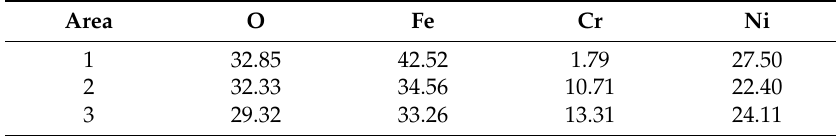
Figure 4. ( a ) Microstructure of the repaired Inconel 718 specimen and ( b ) energy-dispersive spectroscopy (EDS) mapping of the Laves phase. Table 1. EDS analysis results of the areas indicated in Figure 5